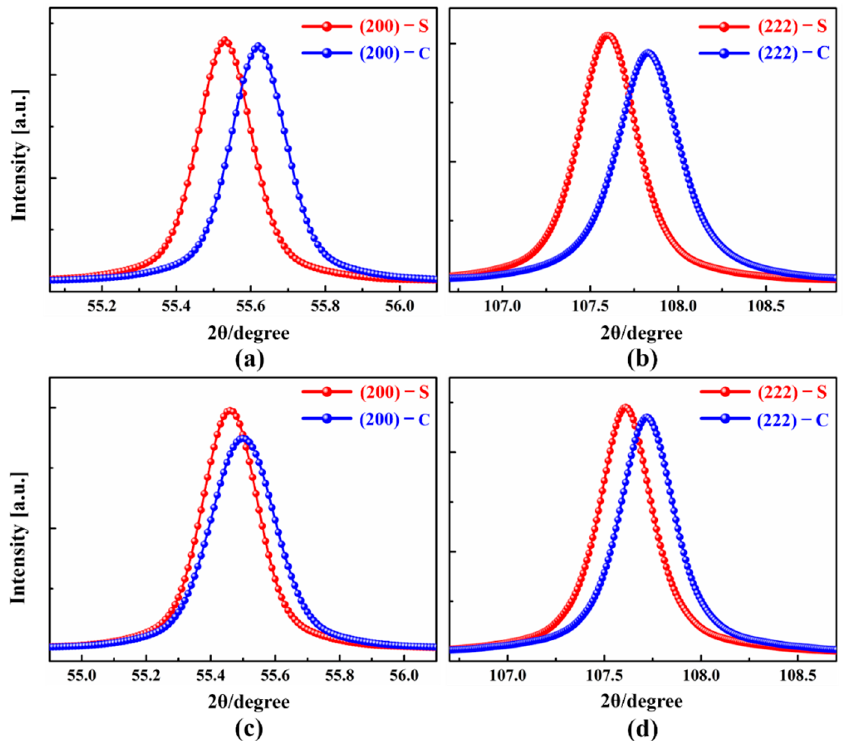
Figure 2. Fitted {200} and {222} diffraction peaks at the surface (S) and center region (C) for UR-Ta and CR-Ta, respectively. ( a ) UR, {200}; ( b ) UR, {222}; ( c ) CR, {200}; and ( d ) CR, {222}. Table 2. The stored energy and relevant parameters used for the stored energy calculations. Position Diffraction Position